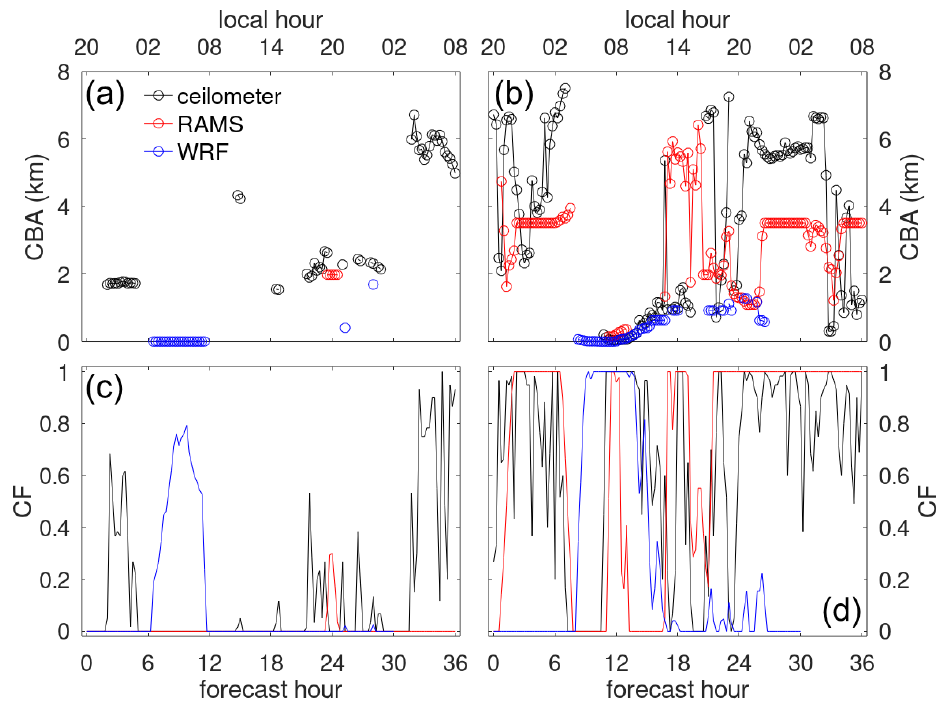
Figure 9. CBA and CF plots for 25 April, ( a , c ), and for 25 May, ( b , d ).